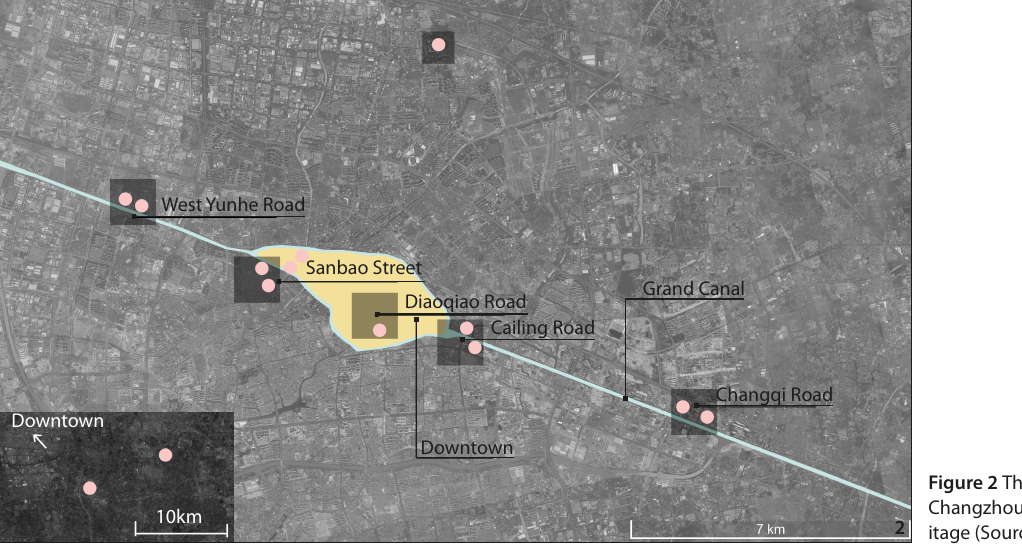
Figure 2 The distribution of Changzhou listed industrial her- itage (Source: the